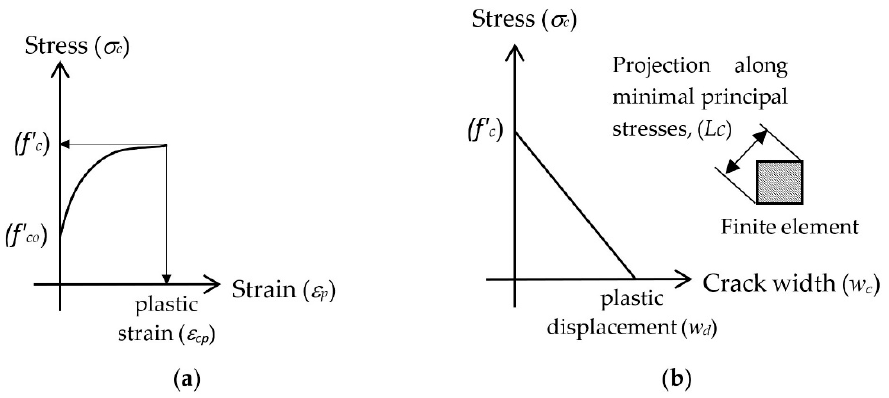
Figure 3. Concrete compressive behavior: ( a ) Compressive hardening; ( b ) Compressive softening. For the concrete stress–strain curve under tension, the curve begins with linear relationship with a slope equal to the concrete modulus of elasticity ( E c ). The relationship stays linear until the tensile stress ( σ t ) reaches the concrete tensile strength ( f t ). Then, the stress– strain relationship turns into exponential decay based on the crack opening displacement ( w t ) computed from the fracturing strain ( ε f ) multiplied by crack band length ( L t ) as in Equation (4). L t is assumed to be equal to the size of the element projected into the crack direction as shown in Figure 4. The fracture energy of the concrete needed to create a unit area of stress-free crack ( G f ) determines the value of crack opening at the complete release of stress ( w tc ).